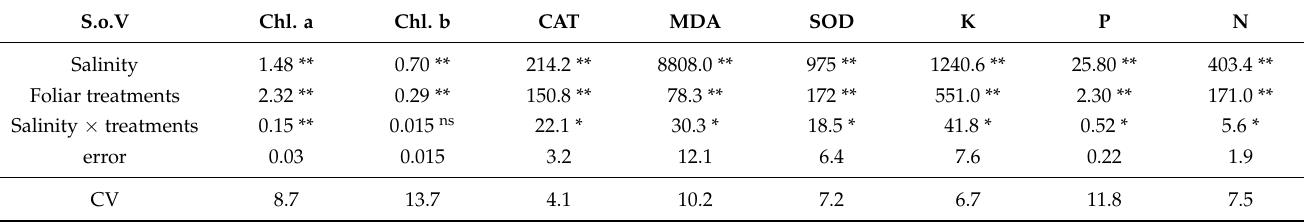
Table 5. ANOVA for the effects of salinity stress and foliar application (without spraying, potassium nitrate, and Zn and Fe nanoparticles) on chlorophyll a and b content, CAT and SOD activity, and MDA and minerals (NPK) content of Aloe vera